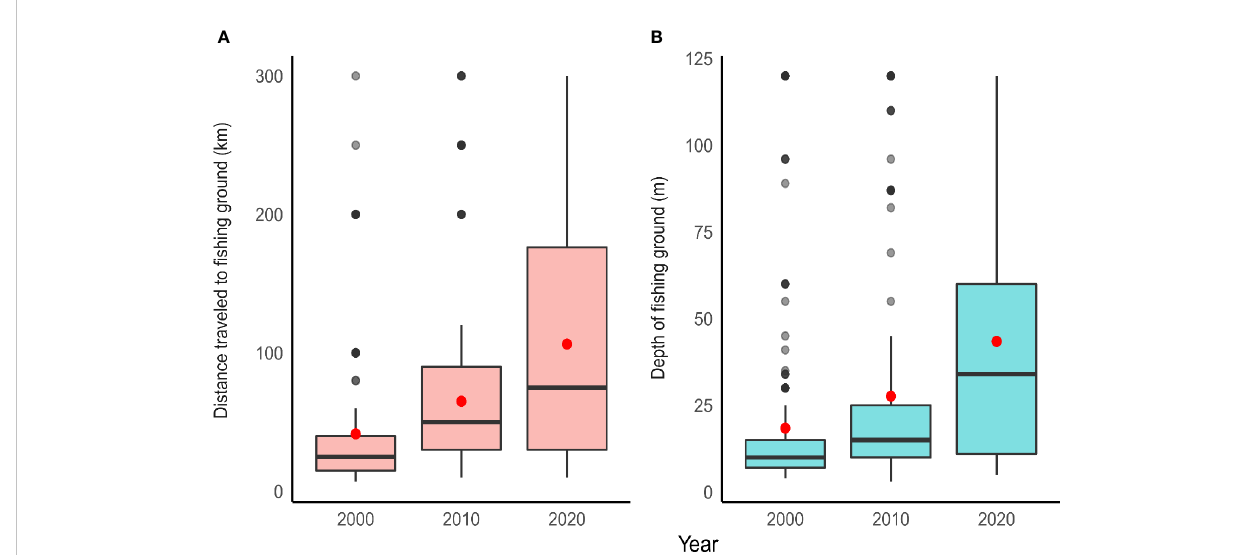
FIGURE 7 (A) Distance traveled by fi shers to reach the fi shing ground. (B) Depth of fi shing grounds in the small-scale marine fi sheries of the Bay of Bengal where fi shers operated for over 20 years. The lower and upper hinges of the boxplots correspond to the fi rst and third quantiles, the middle line corresponds to the mean value, and the whiskers (vertical lines) indicate the highest and smallest values [between 1.5 * the interquartile range (IQR)]. Source: Fishers ’ FGD